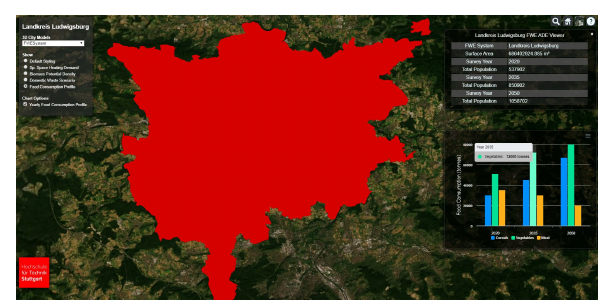
Figure 9. Marbach’s landuse map enriched with soil and crop type (Bao et al., 2020a)